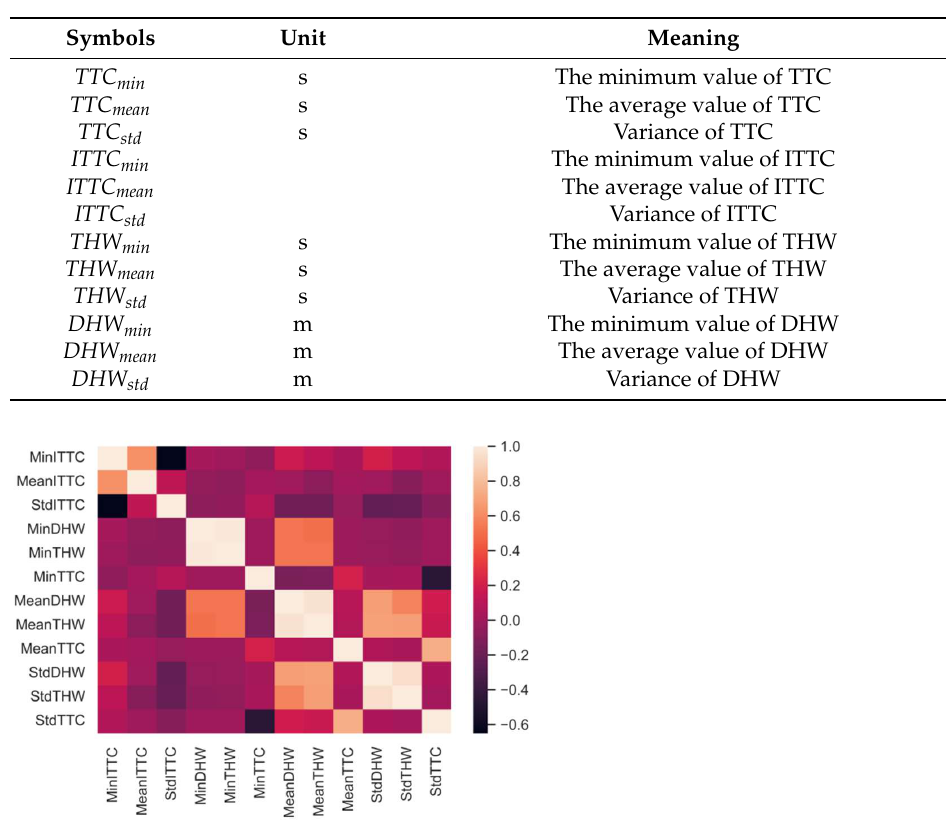
Table 3. List of driving style clustering characteristics.